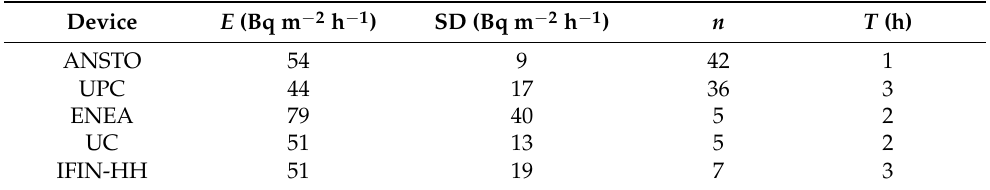
Table 8. Mean radon flux E obtained from the average of n number of measurements carried out in the low radon flux area campaign considering a time period T in the linear fit and the standard deviation SD of the mean.